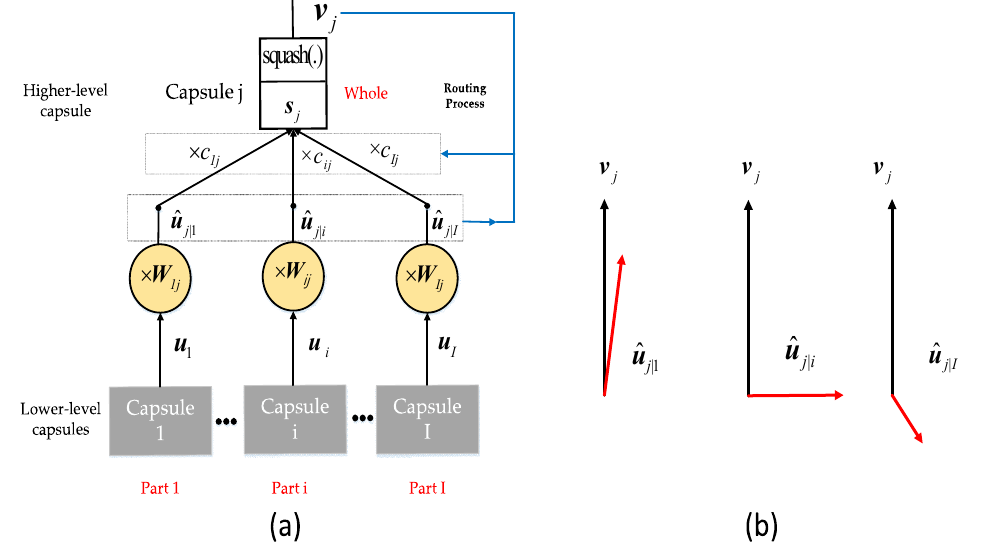
Figure 5. ( a ) Information transfer between capsules; ( b ) Routing process.